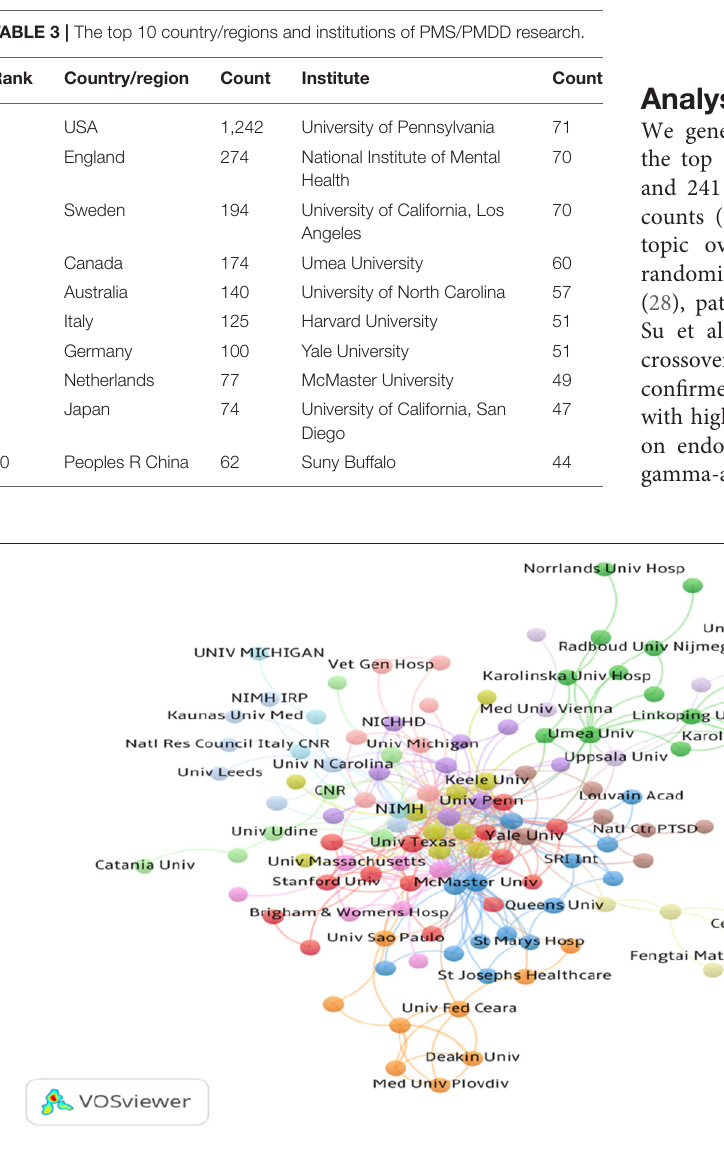
Frontiers in Public Health |